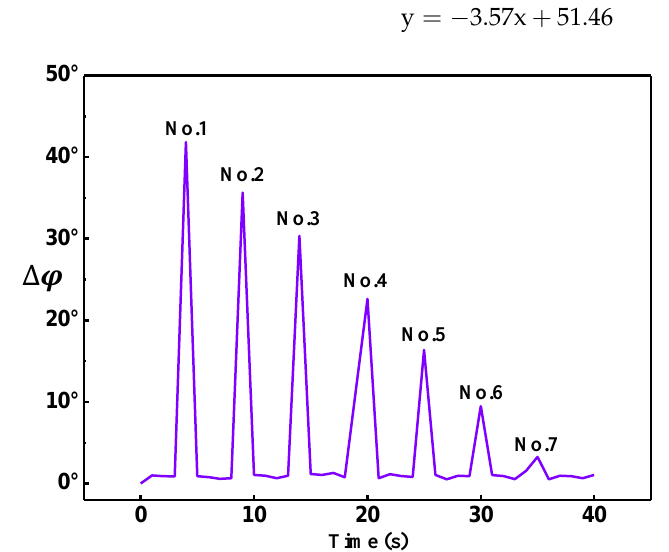
Figure 8. Phase differences for different buried depths.